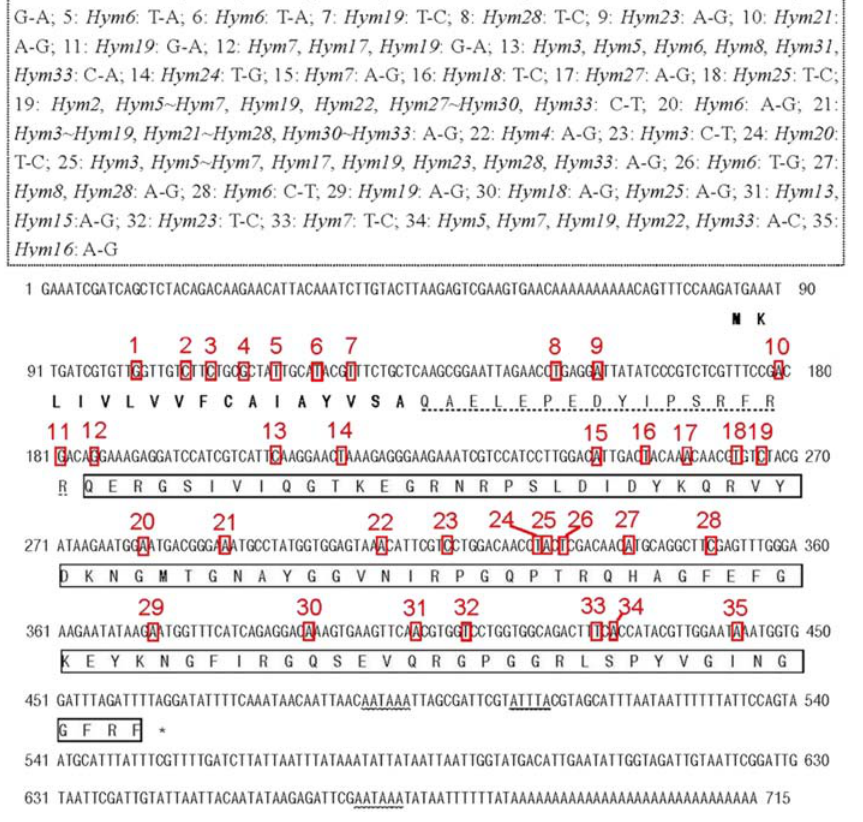
Figure 5. Nucleotide sequence and predicted amino acid sequence of Hymenoptaecin1 (GenBank Accession EU727297). The putative signal peptide is bolded in was black, the proregion of the peptide is shadowed, and the mature peptide is indicated by an open box. The translational signal (TAG) is indicated by the star symbol. Restriction and poly (A) adenylation signals (AATAAA) are indicated by a wavy line. The ATTTA sequence is indicated by a double wavy line. The variant loci are boxed and numbered in red. The nucleotide substitution sites in the precursor sequences between Hymenoptaecin1 and other Hymenoptaecin genes are boxed with a dotted line. ‘‘ Hymenoptaecin1 , Hymenoptaecin34 ’’ is abbreviated to ‘‘ Hym1 , Hym34 ’’.